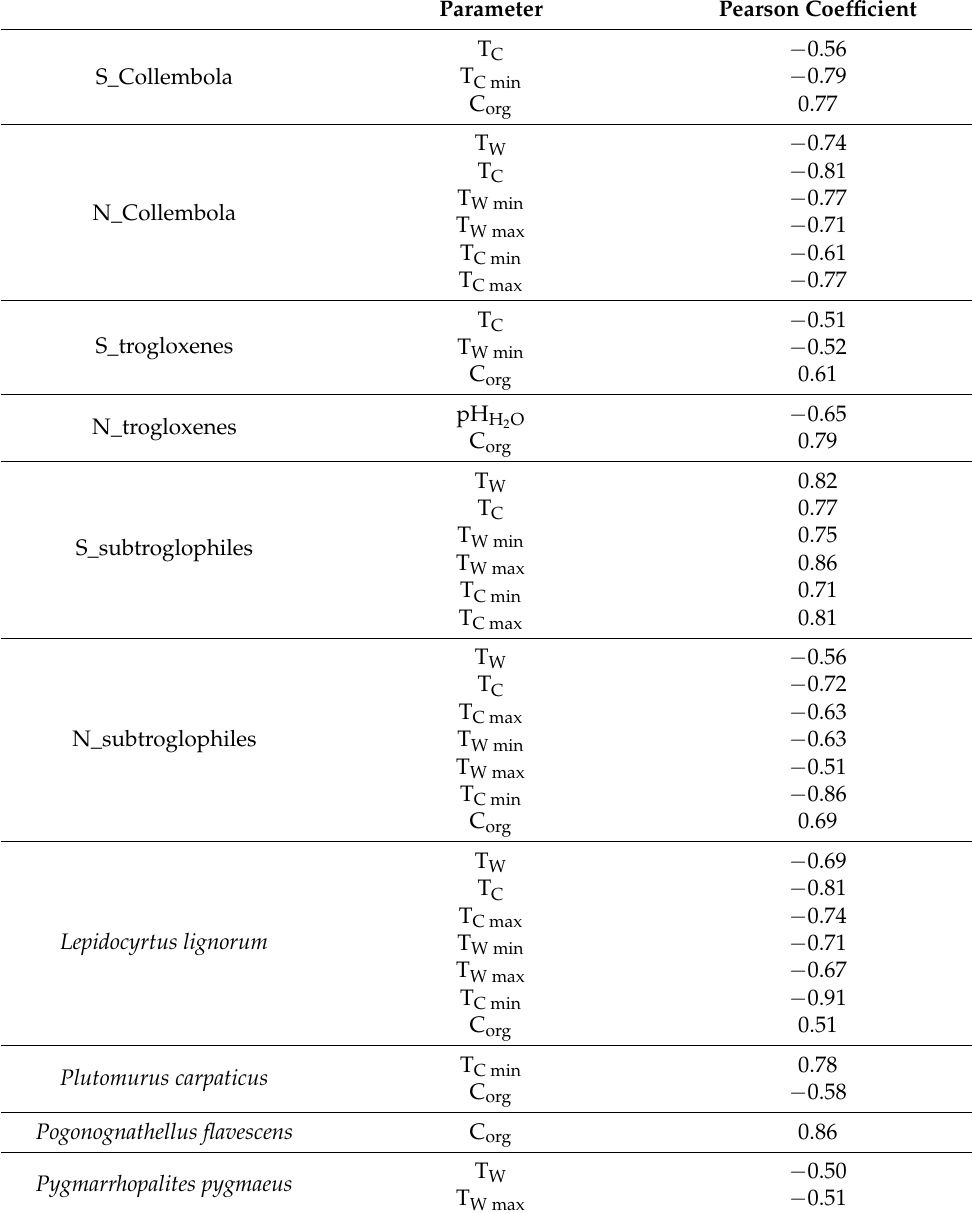
Table 2. Pearson correlation between Collembola, their ecological groups, dominant species and environmental parameters (for both periods soil temperature, pH H richness and abundance counted for depths 5, 35, 65 and 95